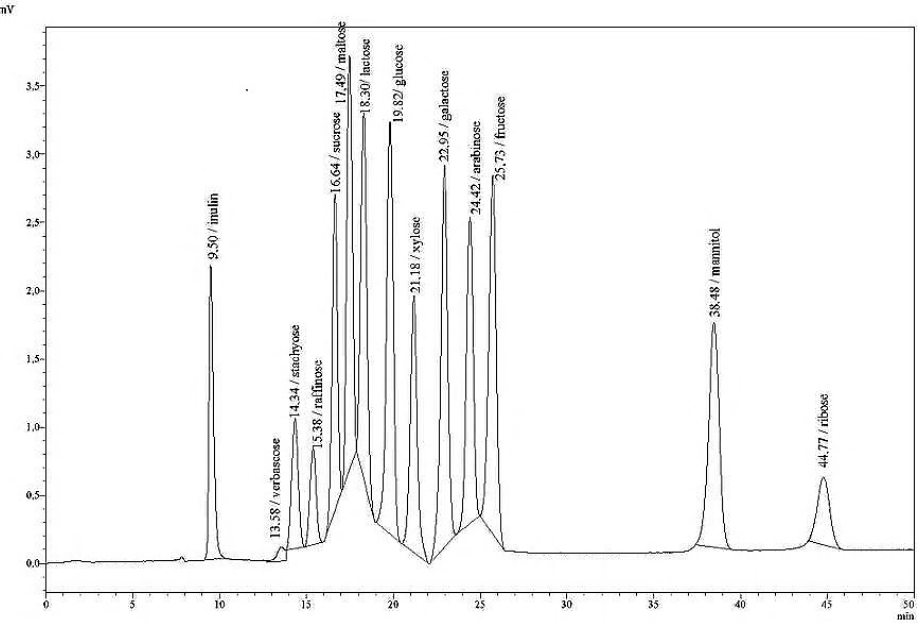
Figure 1. Separation of inulin, mono-, di-, oligo- and polysaccharides in a Pb column Nucleosil CHO 682, at 85 °C, with a RID and HPLC-grade water as the eluent (standard solution). Completeness of separation was checked by recovery studies. The “valley to valley” evaluation method for separated peaks allowed reliable and reproducible identification and quantification. The